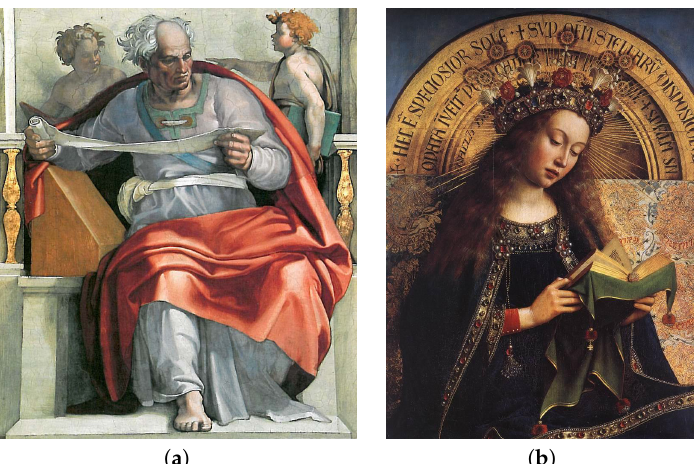
Figure 10. The development of the oil painting technology changed painting as an art form. ( a ) Fresco painting by Michaelangelo on the Sistine Chapel (ca. 1508). The fresco process was difficult and achieved limited tonal range. Today, fresco is defunct as a medium. ( b ) Oil painting by Jan van Eyck for the Ghent Alterpiece (ca. 1430). Much richer colors and lighting are possible with oil paint. Public domain